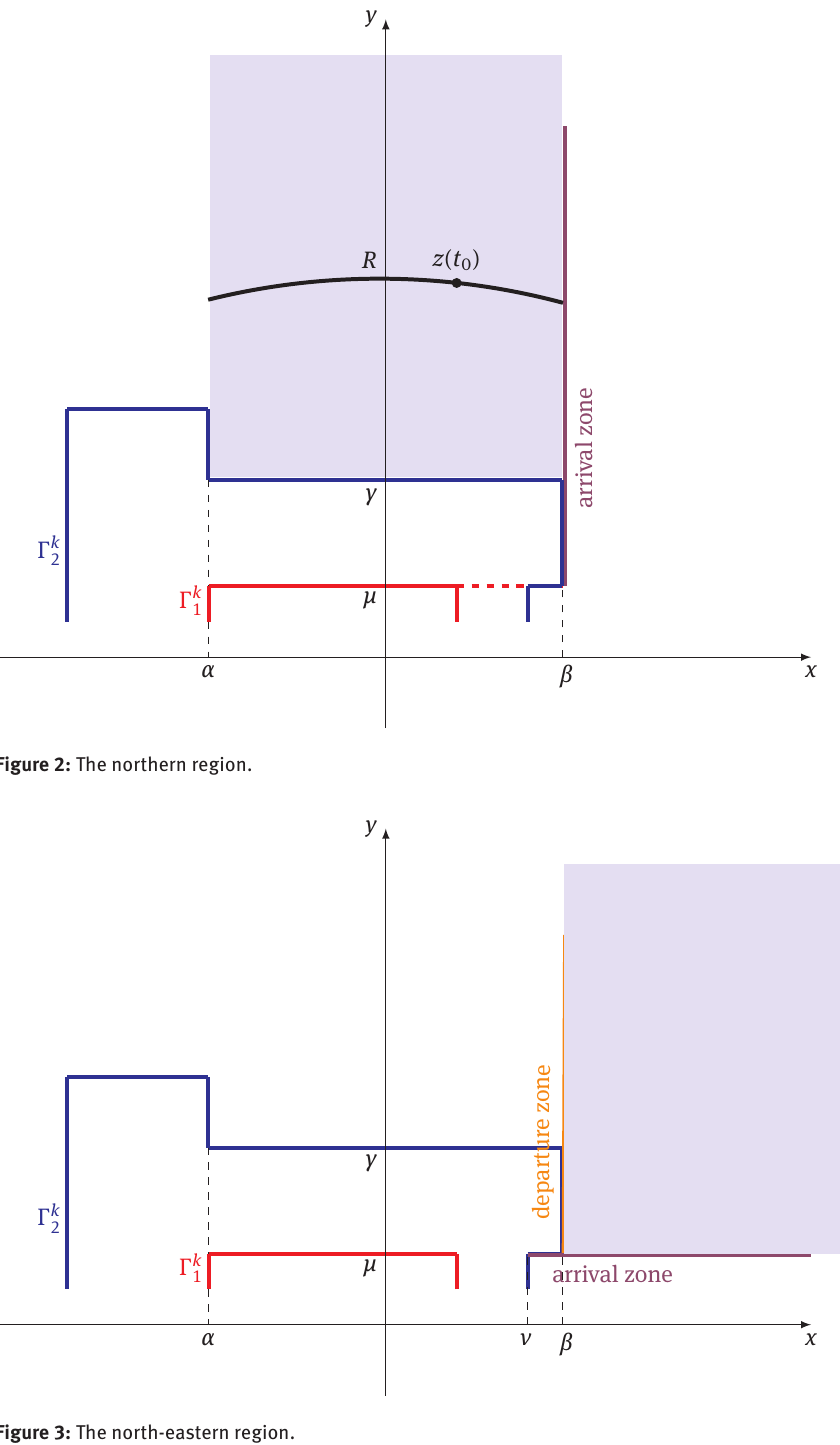
Figure 3: The north-eastern region.